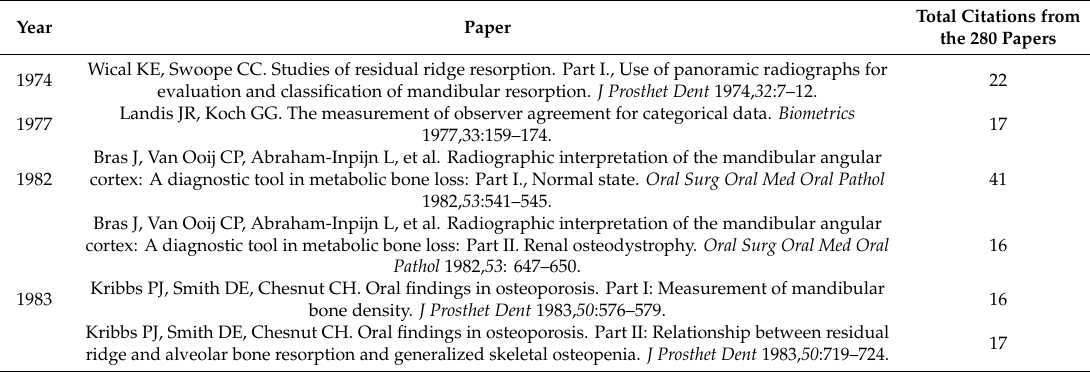
Table 3. Representative references from positive peaks (years 1974, 1977, 1982–1983) of reference publication year spectroscopy (RPYS).